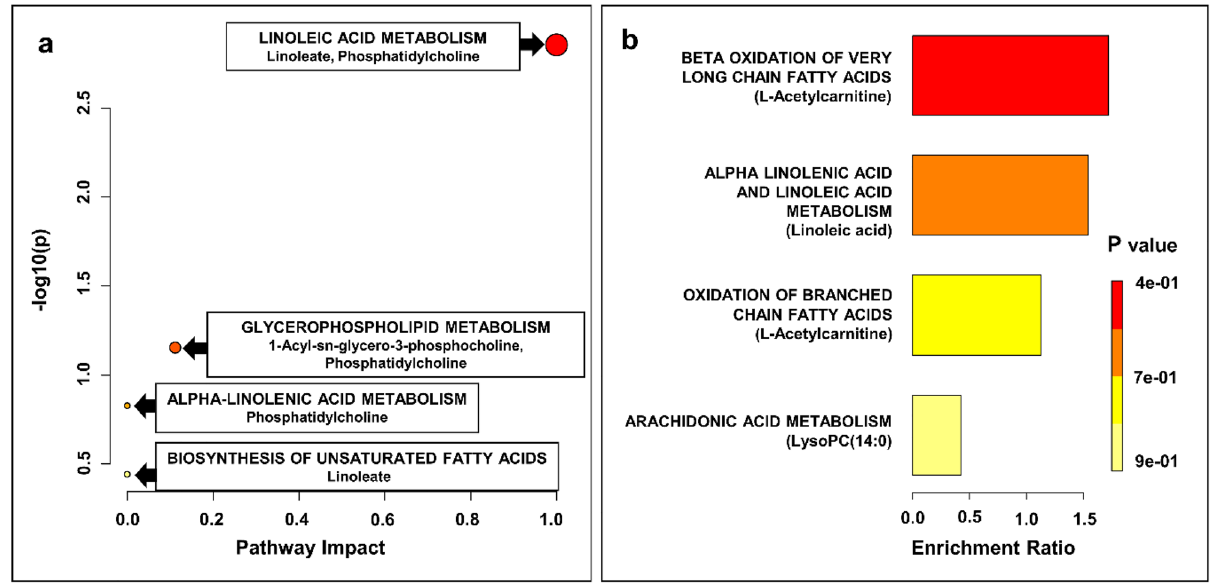
Figure 4. Results of pathway topology analysis of selected statistically significant metabolites in BC. A Pathway analysis based on KEGG ( a ); bubble area donating to the impact of each pathway with color representing the significance from highest in red to lowest in white; ( b ) Quantitative enrichment analysis based on